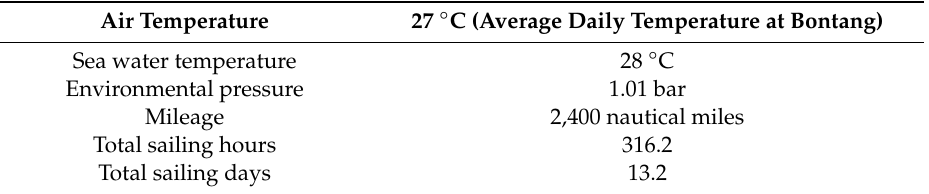
Table 3. Assumed environmental shipping conditions.